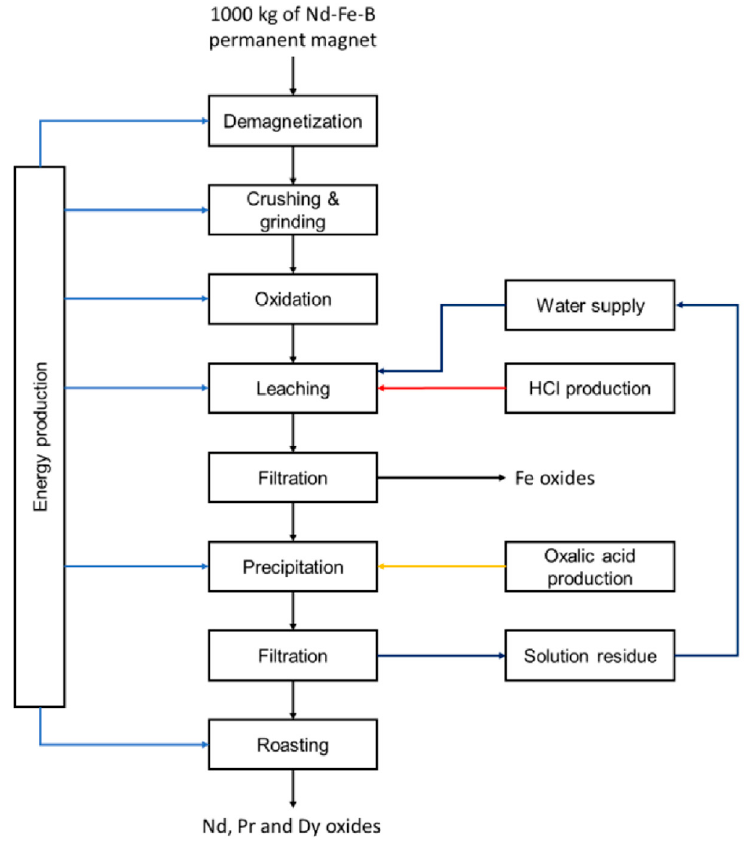
Figure 1. Block diagram of the hydrometallurgical process [9].